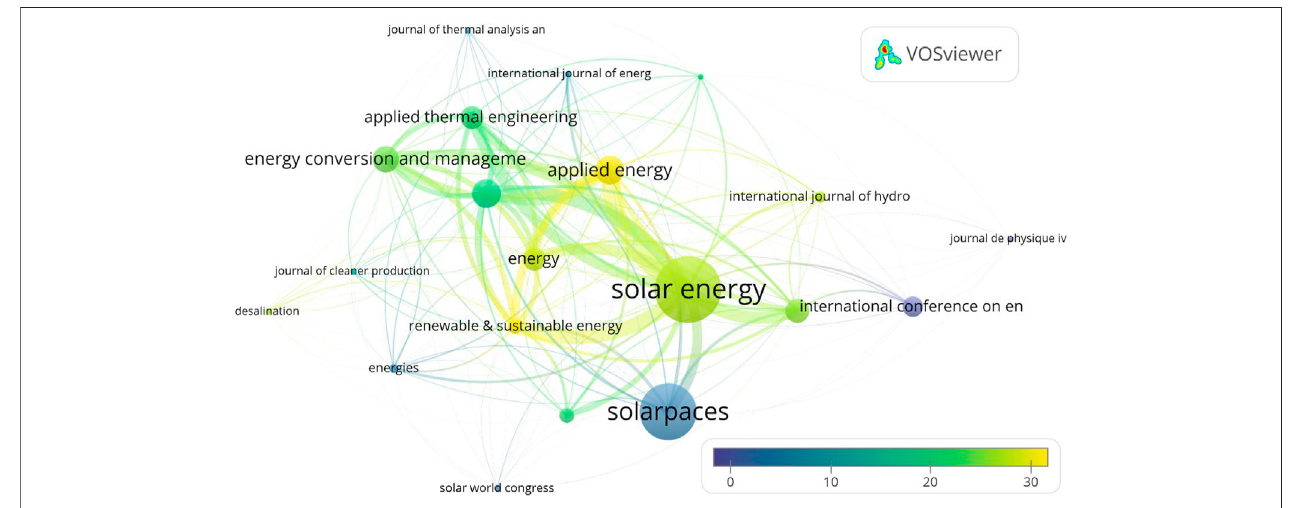
FIGURE 9 | Journal citation relevance and co-citation